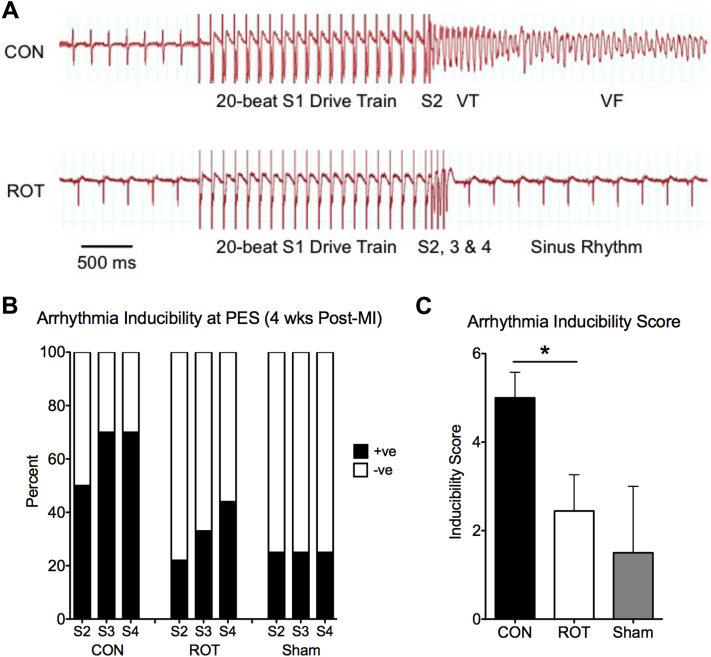
Reduced Arrhythmia Susceptibility on PES in Rotigaptide-Treated Hearts at 4 Weeks Post-MI(A, Top) Example of VT/VF induced in a control (CON) heart during PES. (A, Bottom) Example of PES in a rotigaptide (ROT) heart, with no arrhythmias induced with 3 extrastimuli. (B) Proportions of hearts with VT/VF (duration >1 s) induced with PES. (C) Reduced arrhythmia inducibility scores for rotigaptide hearts (n = 9) compared with that of control MI hearts (n = 10) (*p < 0.05). Data from sham-operated hearts (n = 4) presented for comparison. +ve = PES positive; −ve = PES negative; MI = myocardial infarction; VT/VF = ventricular tachycardia/ventricular fibrillation; other abbreviations as in Figure 1.